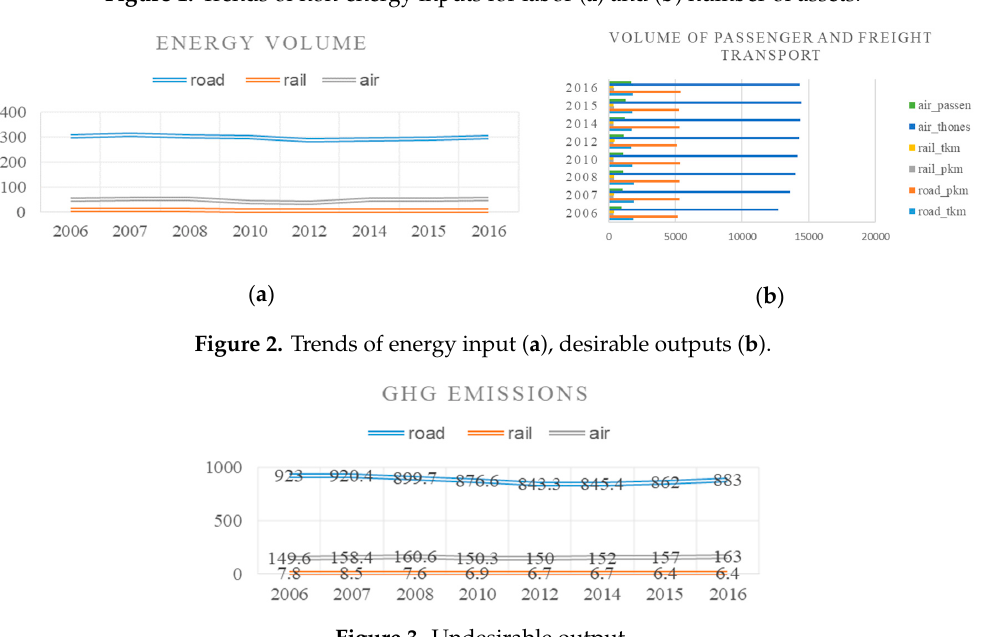
Figure 3. Undesirable output. Figure 2. Trends of energy input ( a ), desirable outputs ( b ).